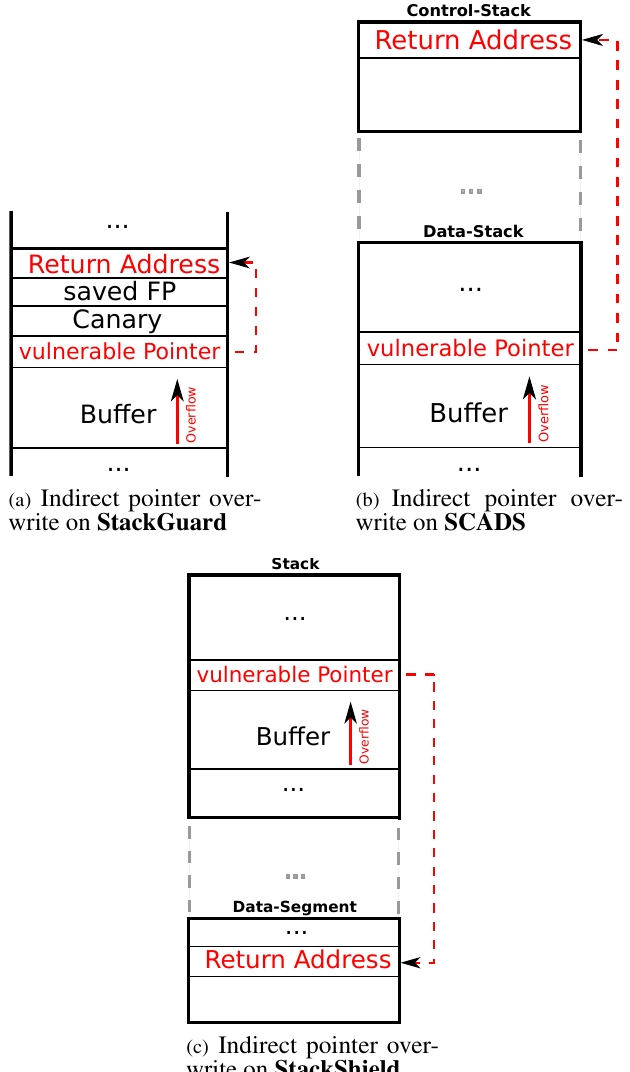
Figure 8. Exploit using an indirect pointer overwrite on StackGuard, StackShield and